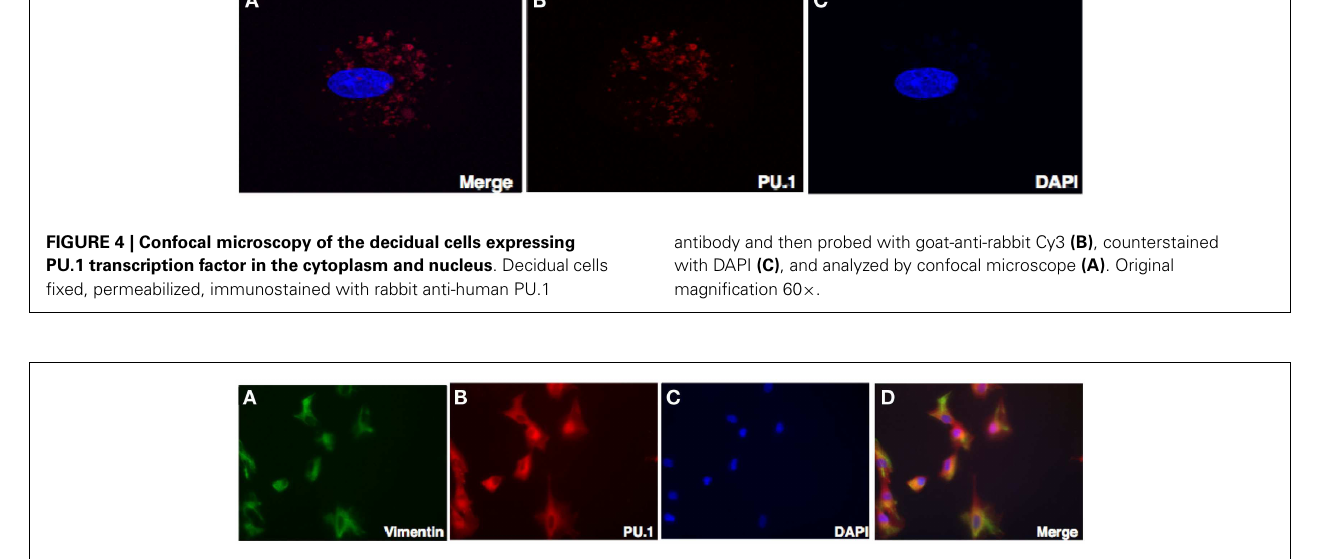
anti-human PU.1 antibody.This was followed by probing with anti-mouse FITC and anti-rabbit Cy3, counterstained with DAPI and analyzed by Axiolmager Z1 fluorescent microscope at 40 × magnifications (A–D) .